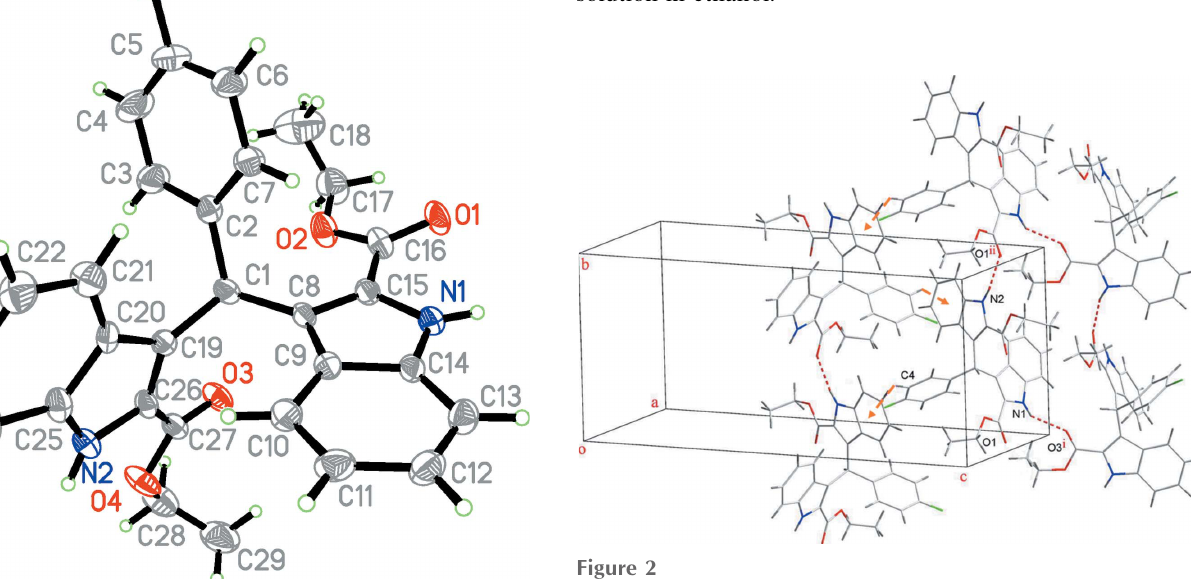
Figure 1 The molecular structure of the title compound, with the atom labelling. Displacement ellipsoids are drawn at the 30% probability